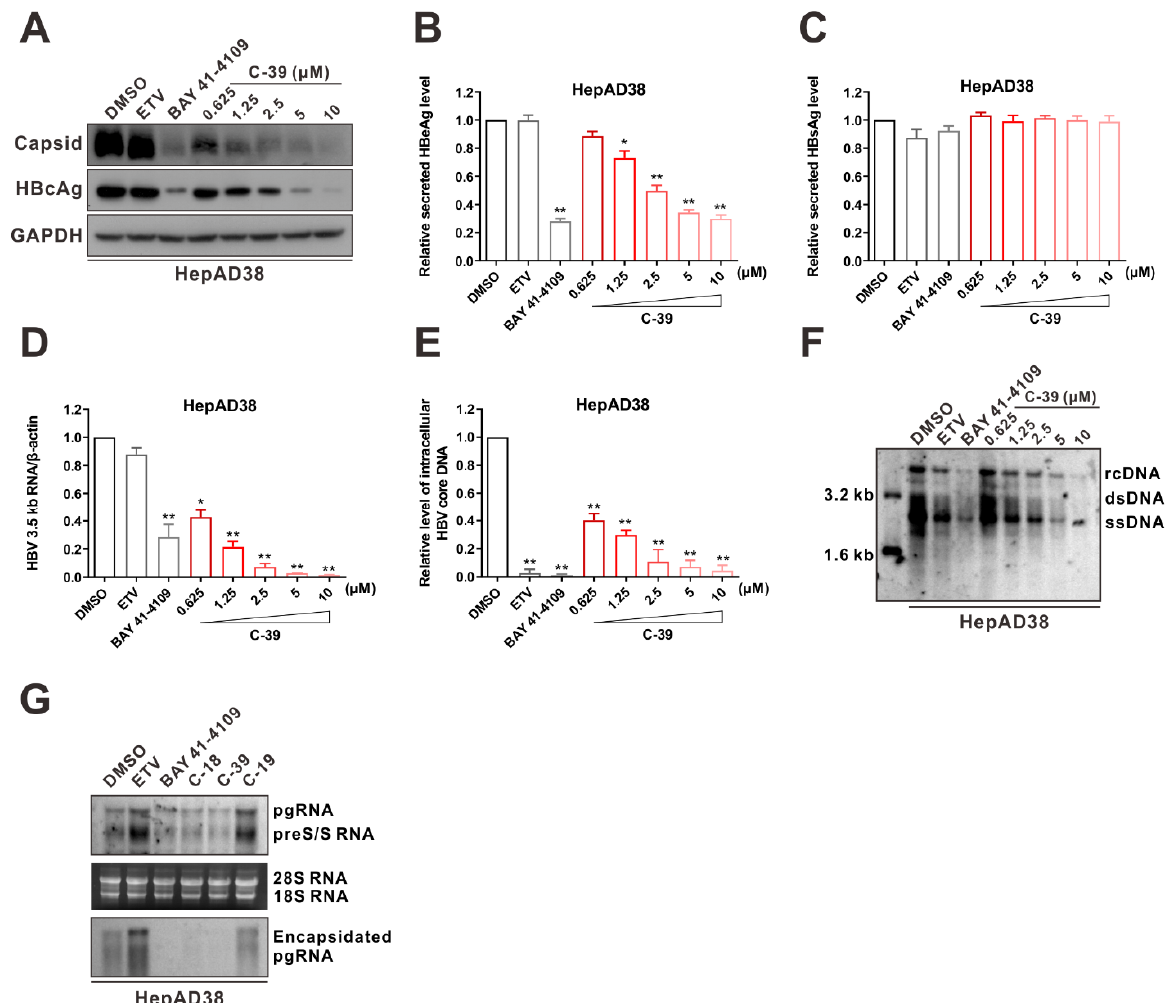
Figure 6 . C-39 significantly inhibits HBV replication. HepAD38 cells were incubated with the indicated concentrations of C-39 for 6 days. ( A ) Effects of C-39 on intracellular HBV capsid formation. HBV capsids and core protein were assessed using the anti-HBV core antibody. ( B – F ) Effects of C-39 on HBV replication. Secreted HBeAg ( B ) and HBsAg ( C ) were determined using ELISA, intracellular HBV 3.5 kb RNA ( D ) and core DNA ( E ) were measured using qPCR, and intracellular HBV replication intermediates (RIs) were assessed using Southern blotting ( F ). ( G ) Effects of C-18, C-39, and C-19 (5 μM) on the HBV total RNAs and encapsidated pgRNA were determined using Northern blotting. ETV (25 nM) and BAY 41-4109 (2 μM) were used as controls. The data in ( B – E ) are representative of three independent experiments and are expressed as mean ± SD (Student’s t -test was used to assess the statistical significance between DMSO group against any other treatment; * p < 0.05, ** p < 0.01).